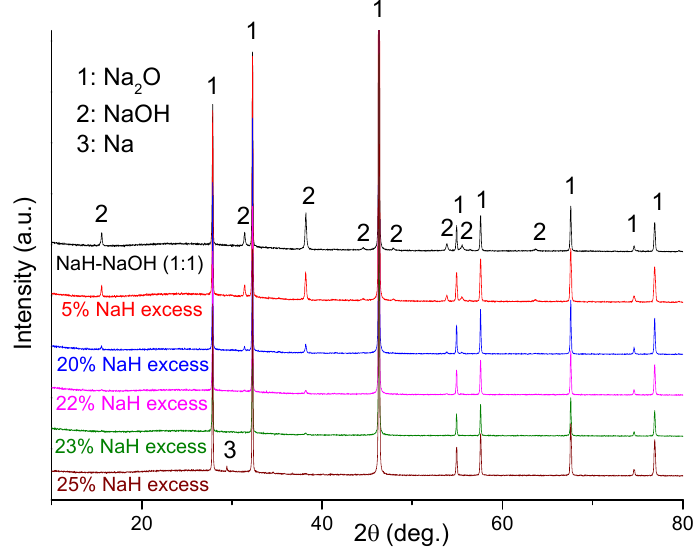
Figure 4. DTA profiles of NaH, NaOH, and as-milled NaH-NaOH (1:1) mixture.